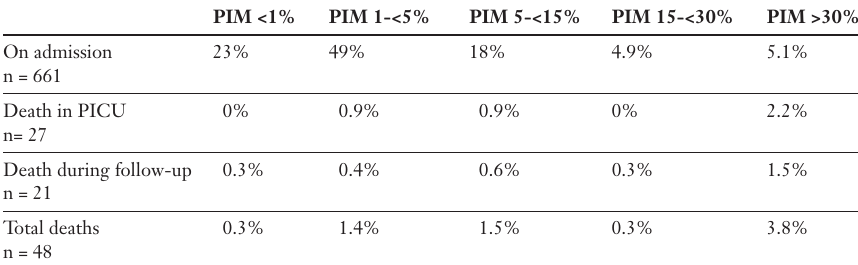
Table 3 Health state classifi- cation (HSC) of all patients with com- plete follow-up (in- cluding deaths) listed in five diagnostic groups at 12 months’ and 24 months’ fol- low-up.